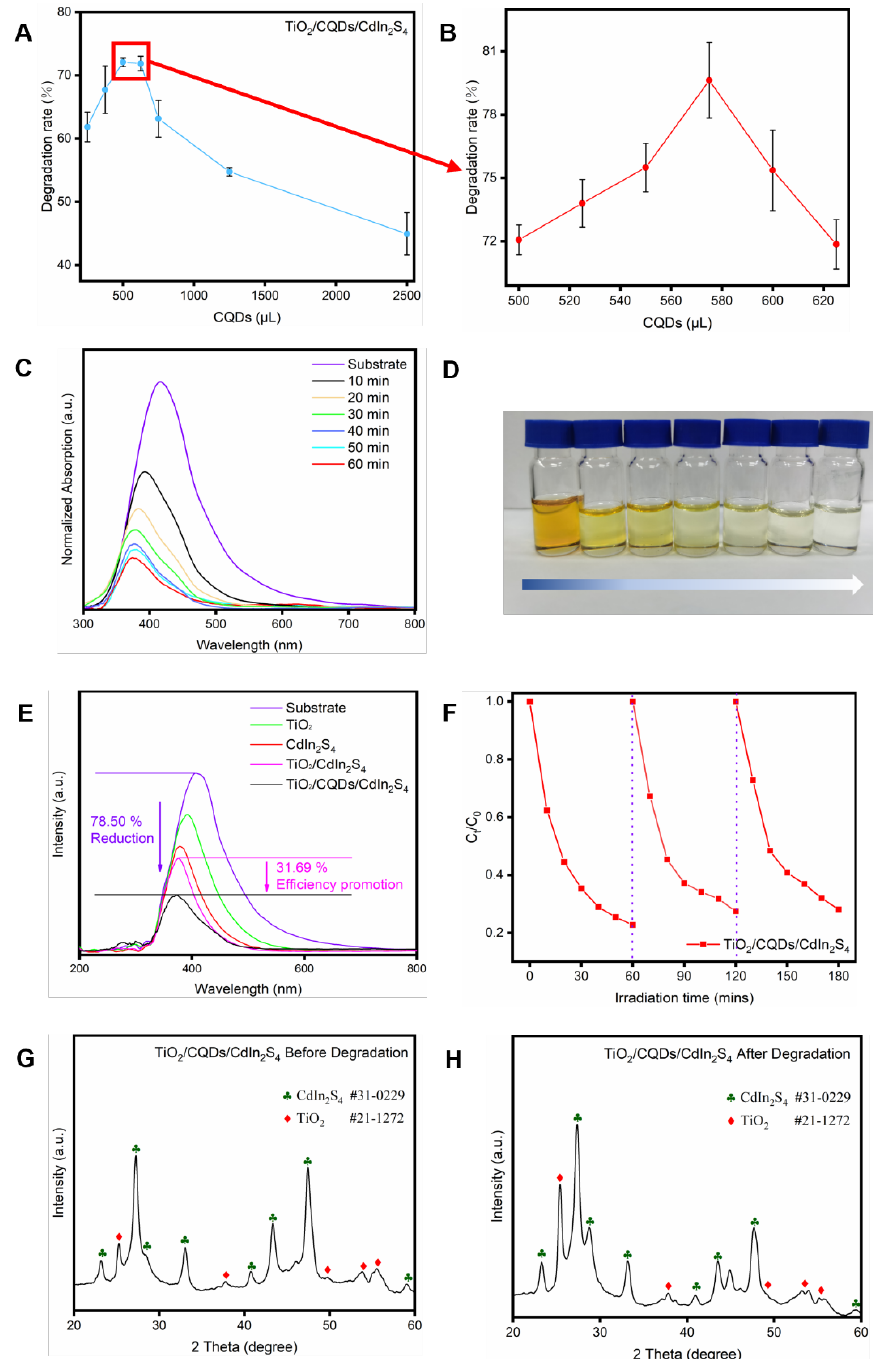
Figure 4. ( A , B ) The PAHs degradation rate by TiO 2 /CQDs/CdIn 2 S 4 with different CQDs content; ( C ) UV-vis DRS of PAHs with different photocatalytic degradation time; ( D ) digital photograph of PAHs with different photocatalytic degradation time; ( E ) UV-vis DRS of PAHs degraded by differ- ent photocatalysts; ( F ) repeated reactions of PAHs degradation over TiO 2 /CQDs/CdIn 2 S 4 ; ( G , H ) PXRD patterns of TiO 2 /CQDs/CdIn 2 S 4 before and after 3 reaction cycles. Reaction conditions: 100 mW cm −2 illumination for 1 h with 50 mg photocatalyst under room temperature. Table 2. Review of photocatalytic degradation performance for PAHs by varies photocatalysts.